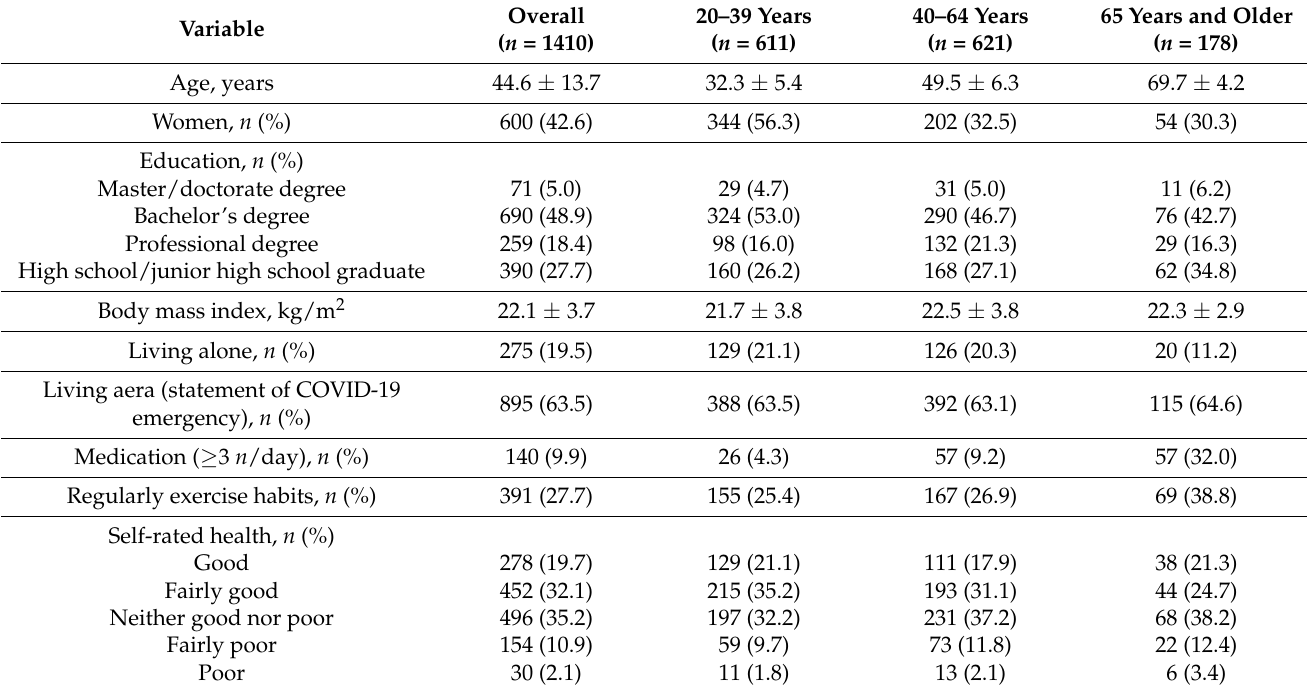
Table 1. Characteristics of